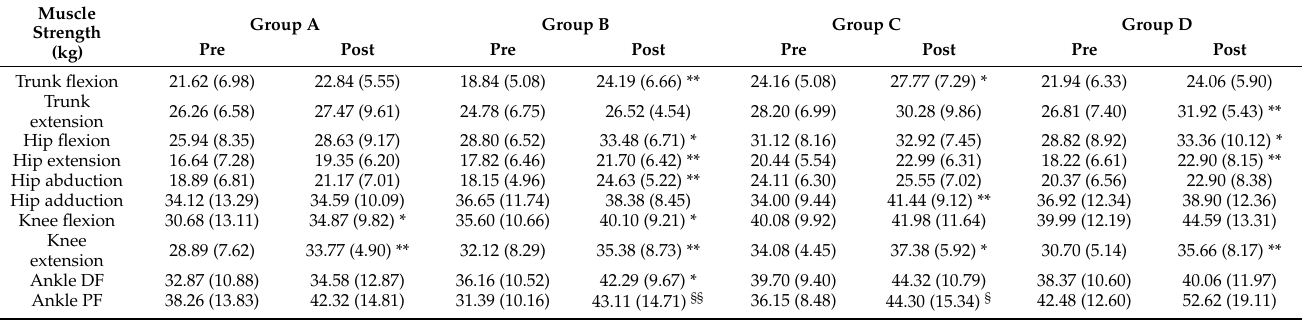
Table 3. Effect of EX1 Exercise on Muscle Strength ( N =